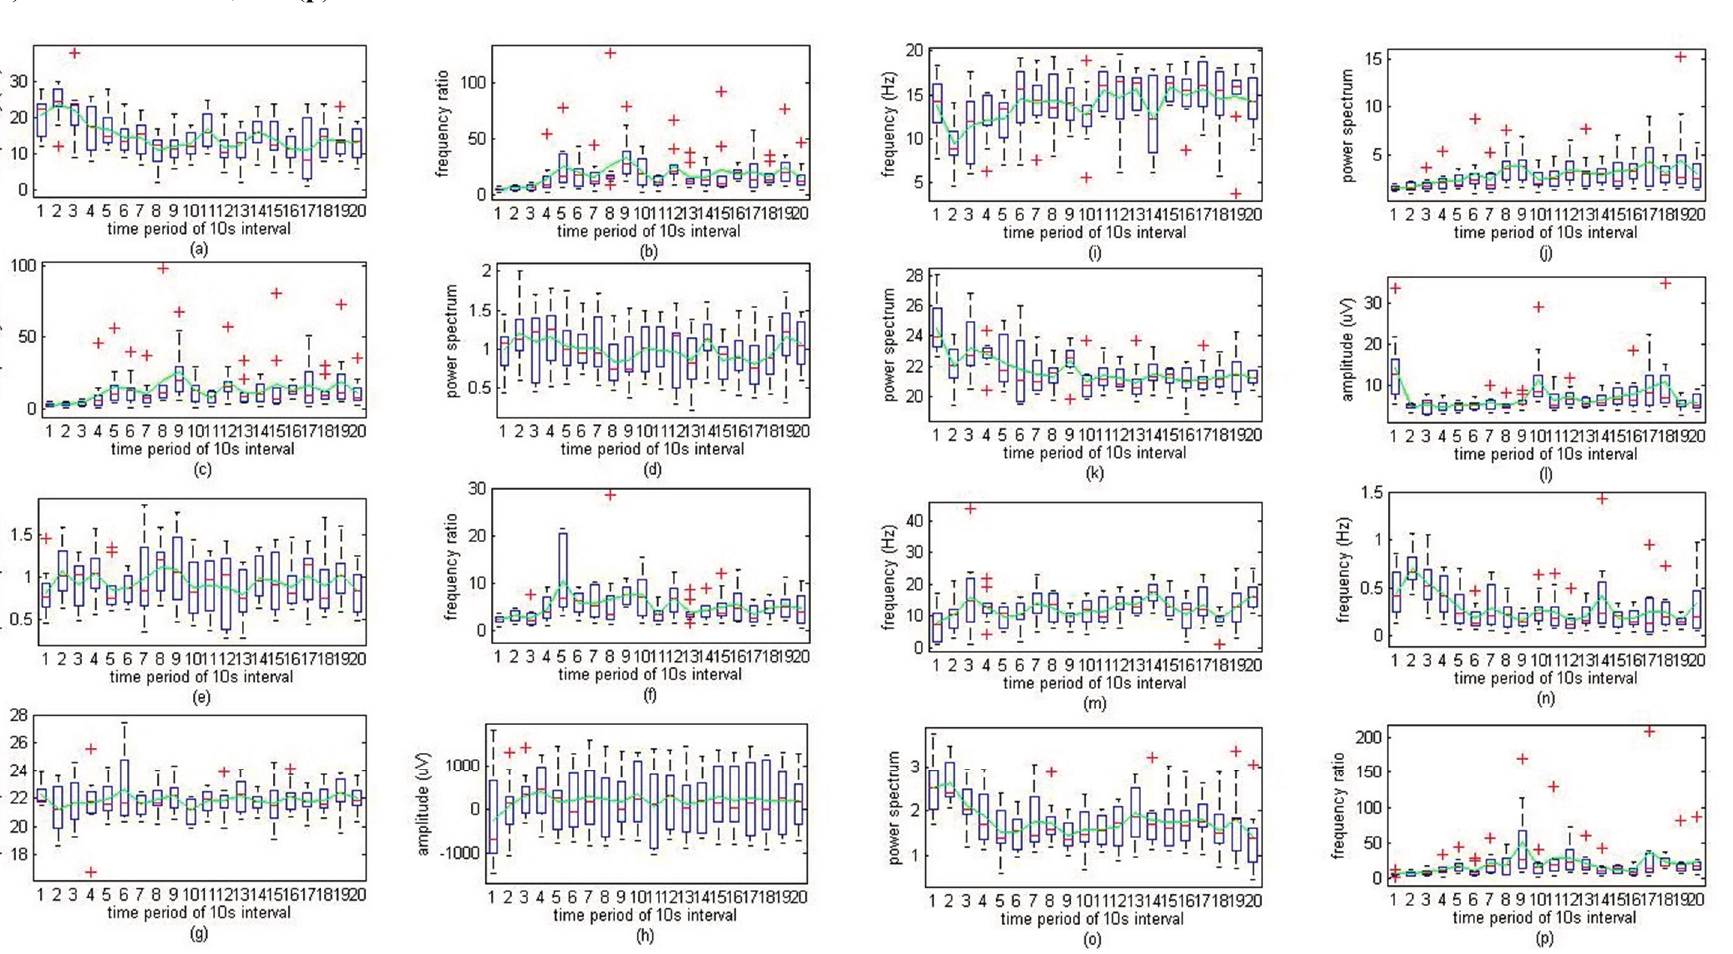
Figure 4. Graphs illustrating a 200-s time segment for volunteer one with 10 s of each of his 16 most descriptive features: ( a ) ABSDELTA